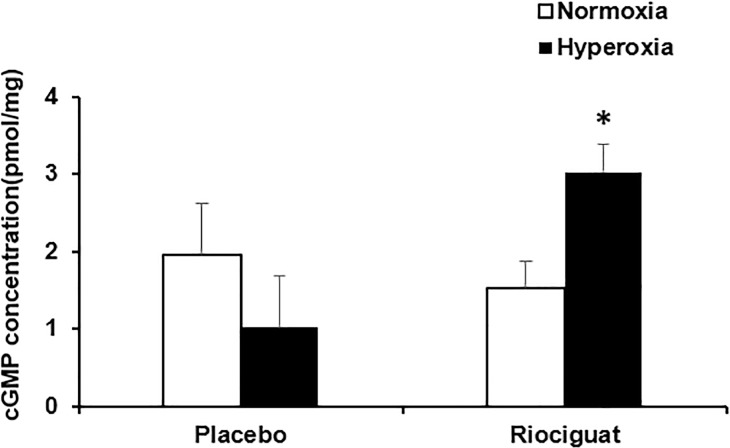
Riociguat increases lung tissue cGMP levels.Riociguat significantly increased cGMP concentration in hyperoxia-exposed rats as compared with placebo treated hyperoxic rats. *P < 0.05 compared with hyperoxia + placebo (n = 4/group).